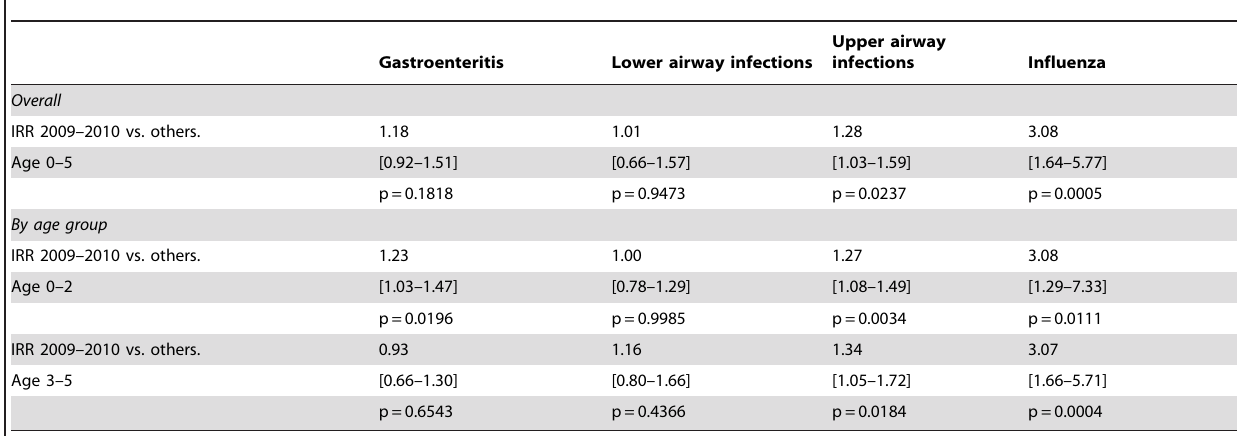
Table 2. Incidence rate ratios of admission rates, season 2009–2010 versus other